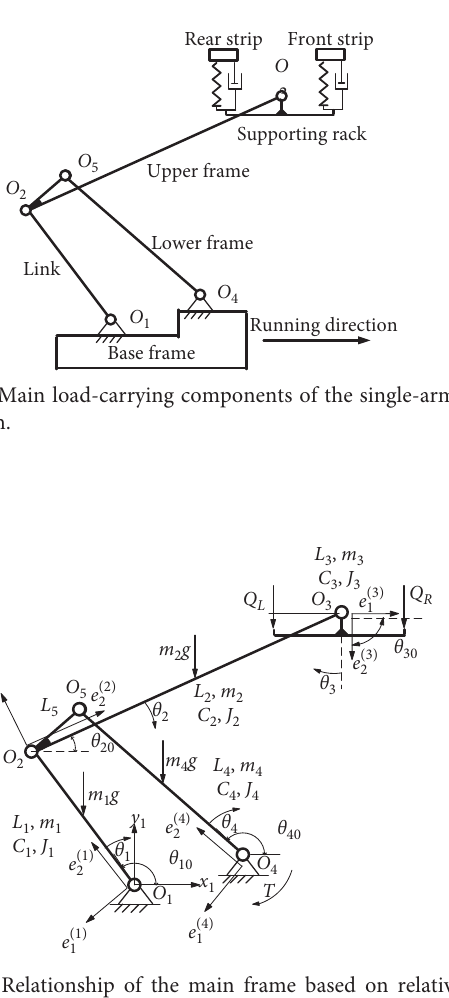
Figure 5: Description of pantograph’s main structure based on the graph theory.